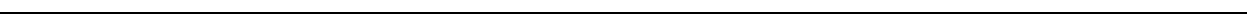
Fig. 6 Parkin inhibits migration and invasion of human breast cancer cells through negative regulation of HIF-1 α . a , b Myc-Parkin expression inhibited the migration ( a ) and invasion ( b ) of different human breast cells as determined by transwell assays. Left panels of a , b : representative images of migrating ( a ) or invading ( b ) MDA-MB231 cells transduced with control (Con) or Myc-Parkin vectors. Scale bars: 200 μ m. Right panels of a , b : quanti fi cation of average number of migrating or invading cells per fi eld. c Knockdown of endogenous Parkin by shRNA vectors promoted the migration and invasion of different human breast cells. d Parkin − / − MEFs displayed enhanced abilities of migration and invasion compared with Parkin + / + MEFs. Left panel: representative images of migrating or invading cells. Scale bars: 500 μ m; Right panel: quanti fi cation of average number of migrating or invading cells per fi eld. e Knockdown of HIF-1 α largely abolished the promoting effect of Parkin knockdown on migration (upper panel) and invasion (lower panel) of cells as measured by transwell assays. Cells with HIF-1 α knockdown were further transduced with control or Parkin shRNA vectors for transwell assays. f Expression of K477R HA-rHIF-1 α largely abolished the inhibitory effect of Myc-Parkin on cell migration (upper panel) and invasion (lower panel) in MCF7 and MDA-MB231 cells. Endogenous HIF-1 α in cells was replaced with WT or K477R HA-rHIF-1 α (shown in Fig. 5g), and cells were then transduced with Myc-Parkin for transwell assays. g C431A, T173A, T240M and P294S mutations of Parkin compromised the inhibitory effects of Parkin on cell migration (left panel) and invasion (right panel). In a – g , the data present mean ± SD ( n = 6). #: P < 0.05; * P < 0.01; ** P < 0.001; two-tailed Student ’ s t